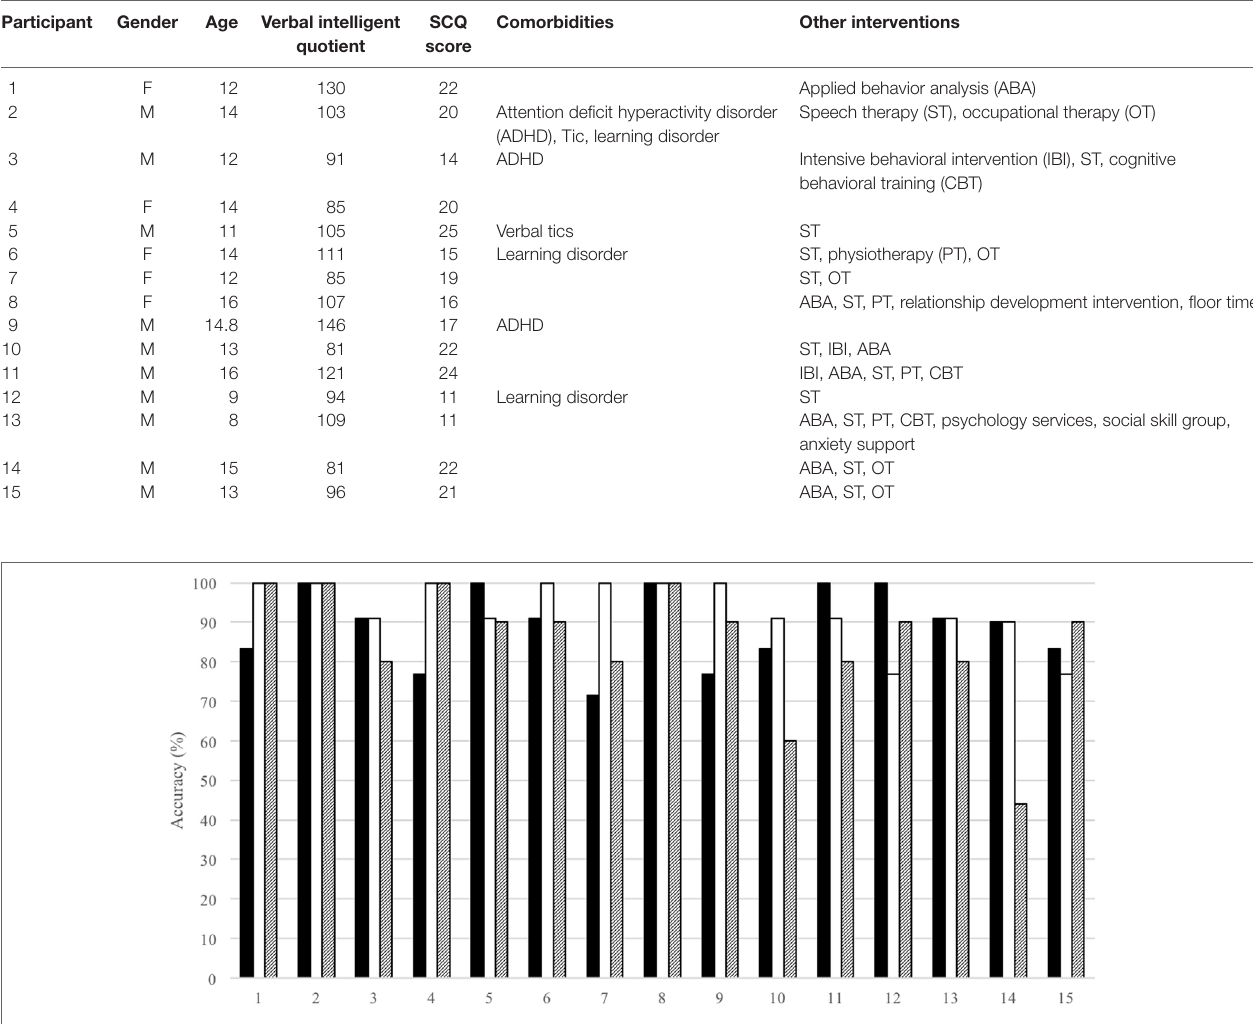
Table 1 | Participant characteristics.